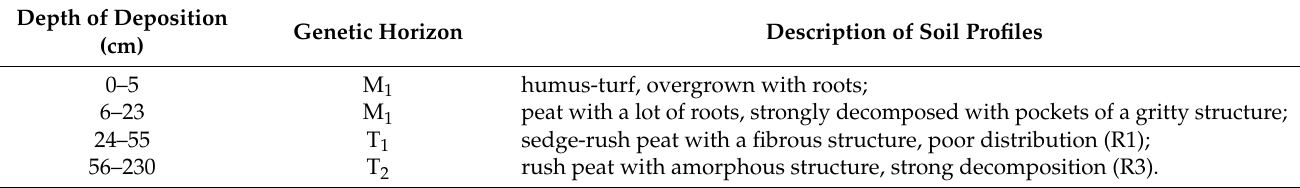
Table 1. Soil profile before establishment of experiment with reseeding of T. repens.